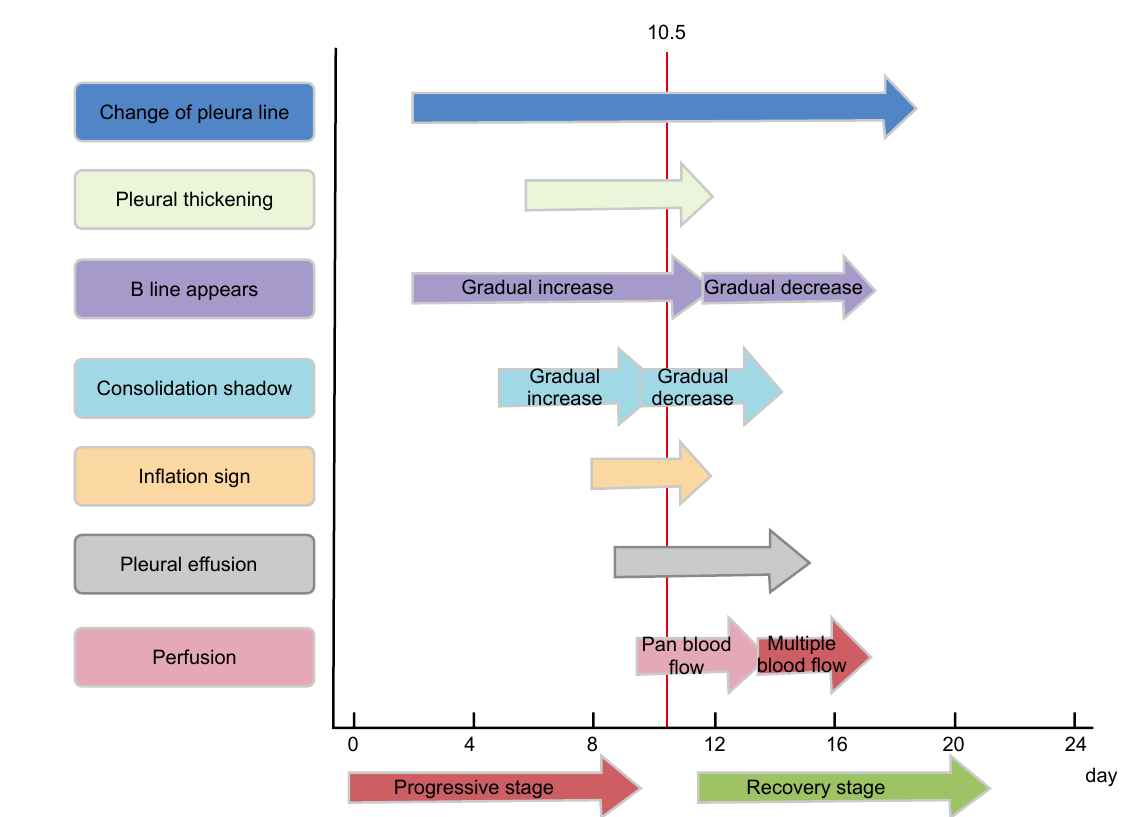
Figure 2 The ultrasonic findings at different stages.